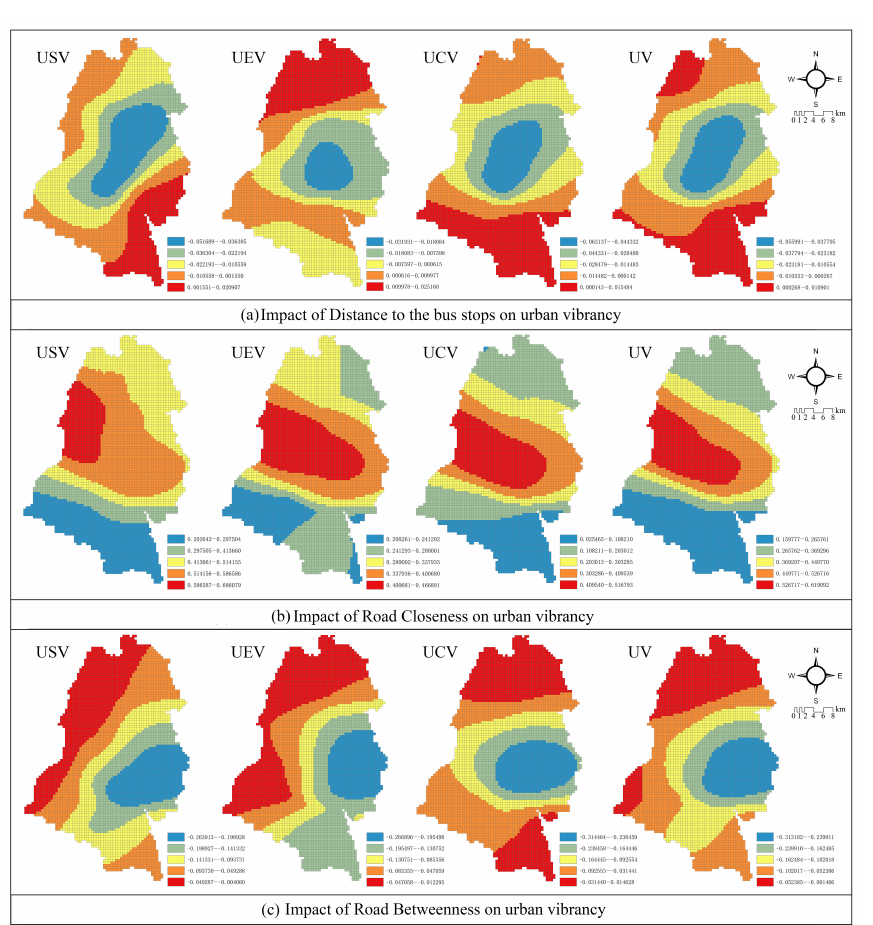
Figure 7. Impact of road transportation networks on various urban vibrancy. ( a ) Impact of Distance to the Bus Stops on Urban Vibrancy. ( b ) Impact of Road Closeness on Urban Vibrancy. ( c ) Impact of Road Betweenness on Urban